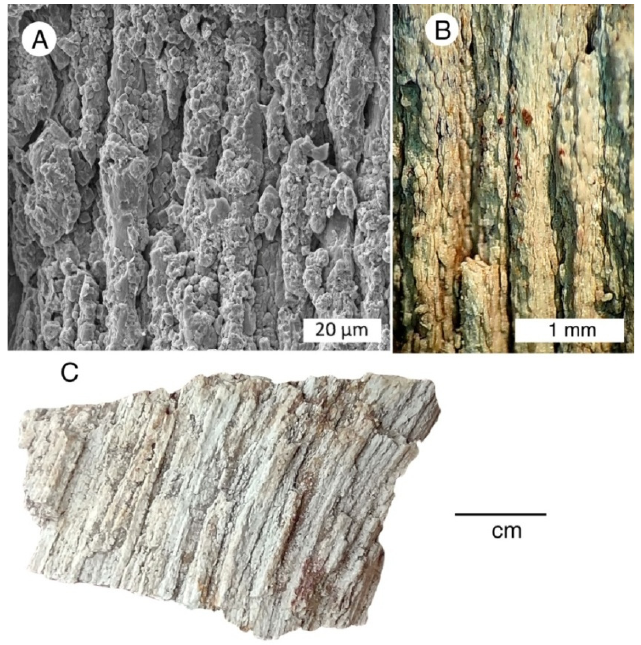
Figure 6. Tak fossil wood from log #1. ( A ) SEM view of longitudinal surface. ( B ) Low-power optical microscope image. ( C ) Specimen showing cells coated with quartz crystals. All images show incomplete mineralization, where intercellular spaces remain open.